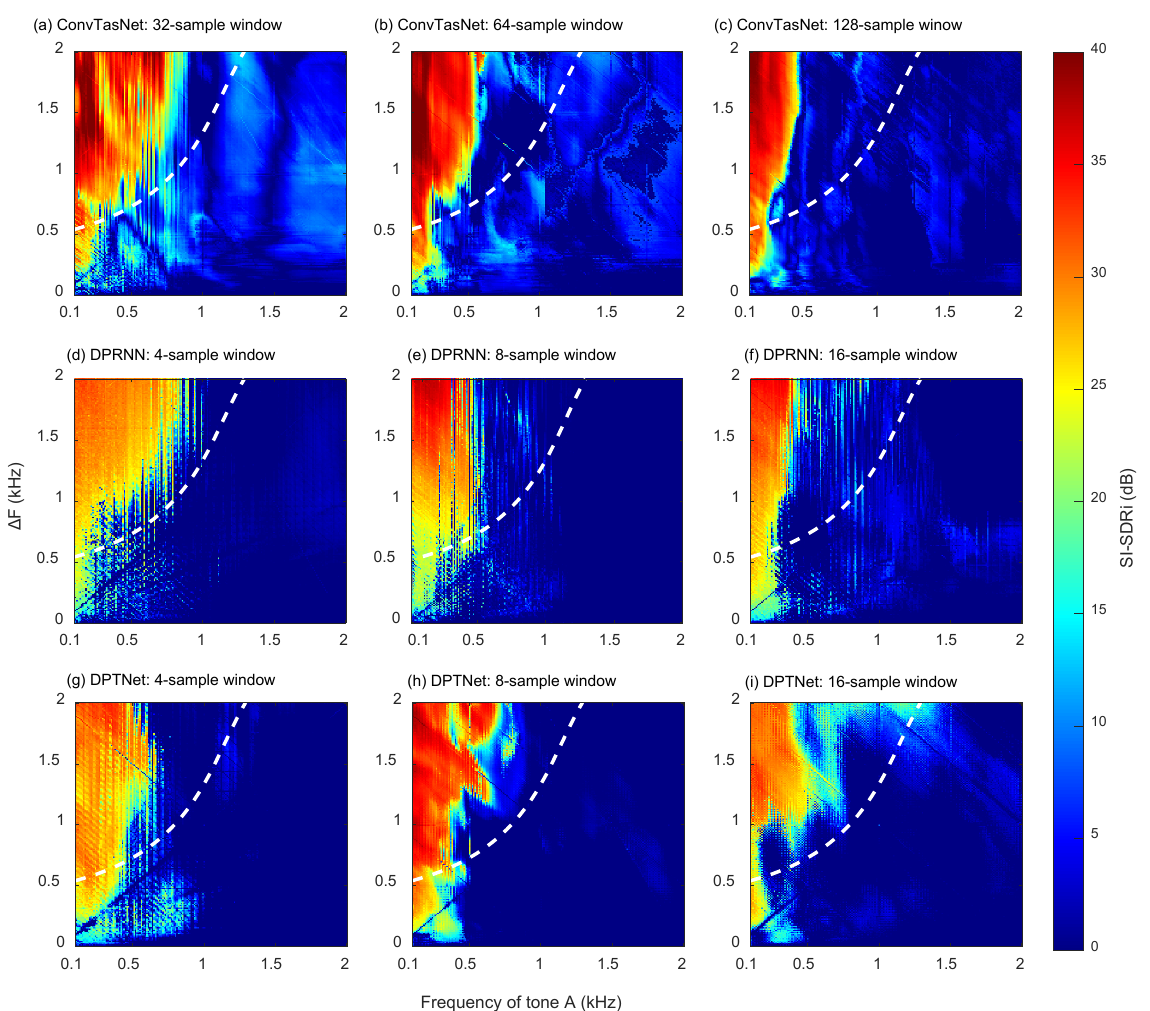
Figure 5. SI-SDRi (dB) as a function of the frequency of tone A (kHz) and ∆ F (kHz), where ( a – i ) represent results of three well-trained networks (ConvTasNet, DPRNN, and DPTNet) with three different parameters, respectively. The dashed white curve is the ∆ F separable threshold at each frequency in the human auditory system.